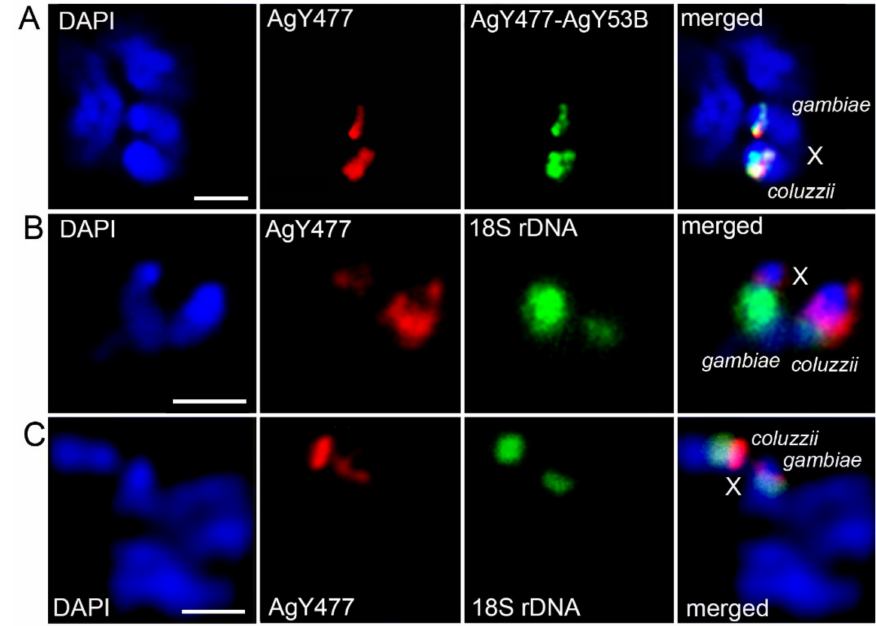
Figure 5. Variation in the pattern of heterochromatin blocks, rDNA loci, and satDNA location on the X chromosomes in F1 female hybrids between An. gambiae and An. coluzzii. ( A ) FISH of AgY477–AgY53B (green) and AgY477 (red) in F1 (cid:25) An. gambiae PIMPERENA × (cid:26) An. coluzzii MOPTI. ( B ) FISH of AgY477 (red) and 18S rDNA (green) in F1 (cid:25) An. gambiae ZANU × (cid:26) An. coluzzii MALI. ( C ) FISH of AgY477 (red) and 18S rDNA (green) in F1 (cid:25) An. coluzzii MOPTI × (cid:26) An. gambiae KISUMU. Scale bar = 2 µ